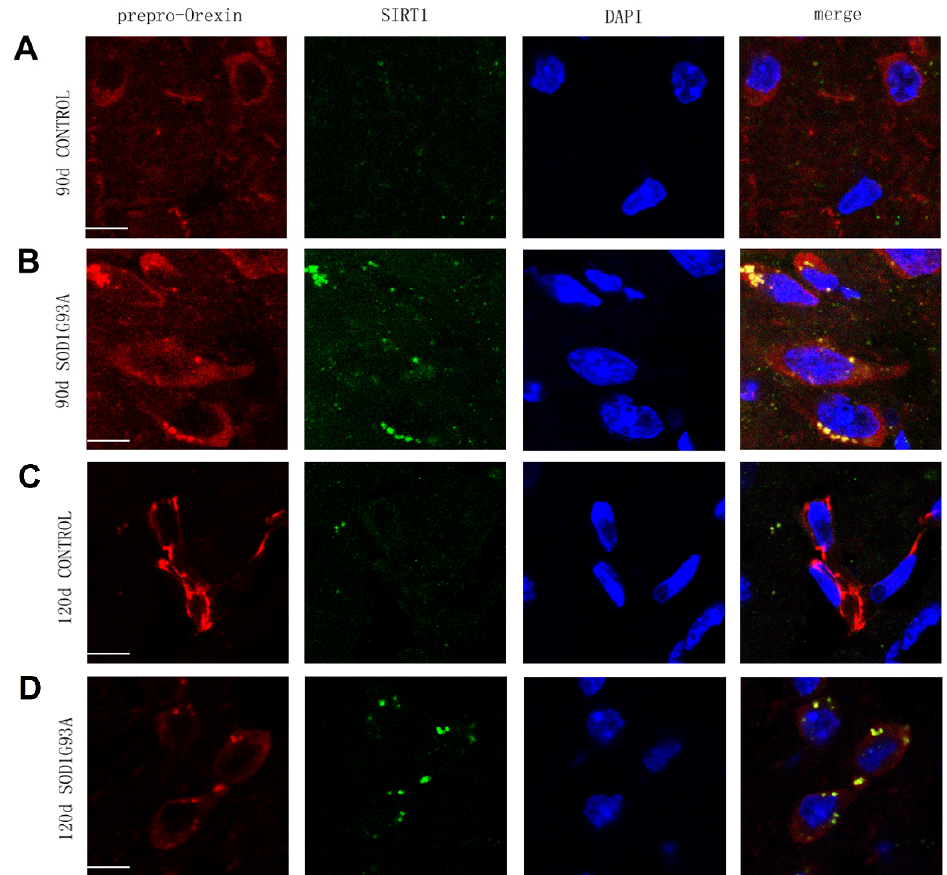
Figure 2. Immunofluorescence demonstrating that prepro-orexin interacts with SIRT1 in the cy- toplasm of neurons in lateral hypothalamus in SOD1G93A transgenic mice. The merged image shows the colocalization (yellow) of prepro-orexin and SIRT1 in the hypothalamus in 90 days ( B ) and 120 days SOD1G93A transgenic mice ( D ) but not in 90-d ( A ) and 120-d control mice ( C ). Scale bar = 10 µm. Prepro-orexin (red); SIRT1 (green); DAPI (blue).